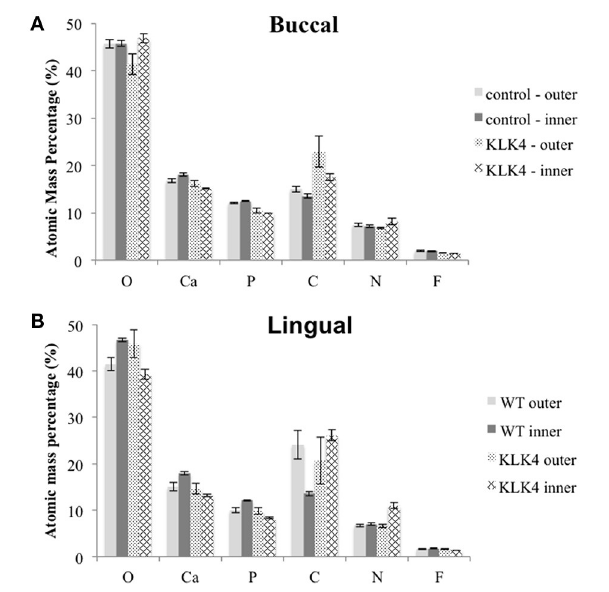
FIGURE 4 | Elemental analysis by energy dispersive X-ray spectroscopy (EDX). Measurements are detailed in Supplementary Table 10. Note that Mg and Na content were also analyzed but are not included here. Measurements were taken from both sides of the tooth: (A) : buccal, (B) :